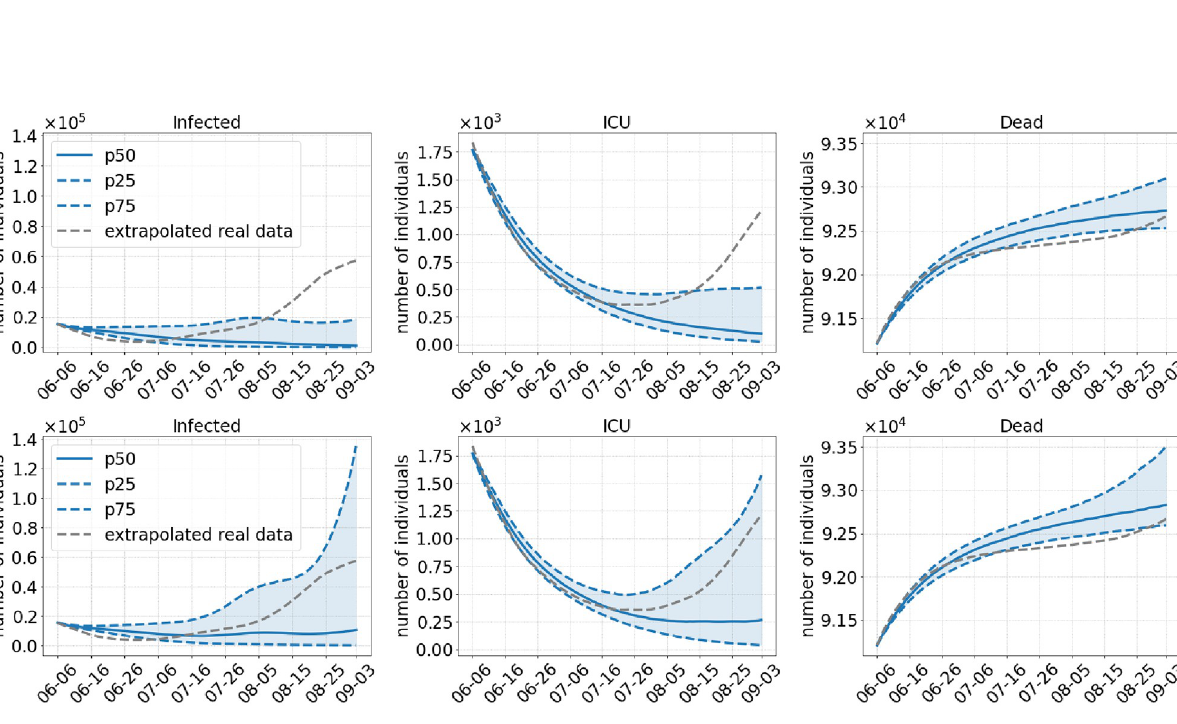
Fig 8. Results of Scenario 4: Commuter testing once a week with local NPIs decreed until August 01, 2021, keeping masks and distancing after opening. The median of 500 runs is shown in solid blue; the blue dotted lines are the 25% and 75% percentiles. The top row shows results with an assumed 40% more transmissible Delta variant compared to 60% in the bottom